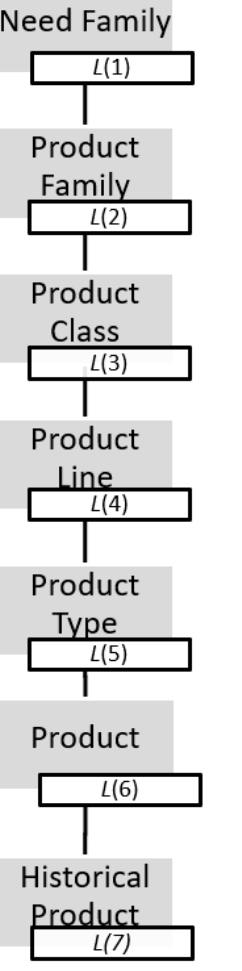
Figure 4. Product hierarchy, adapted from (Kotler, [ 90 ] ).